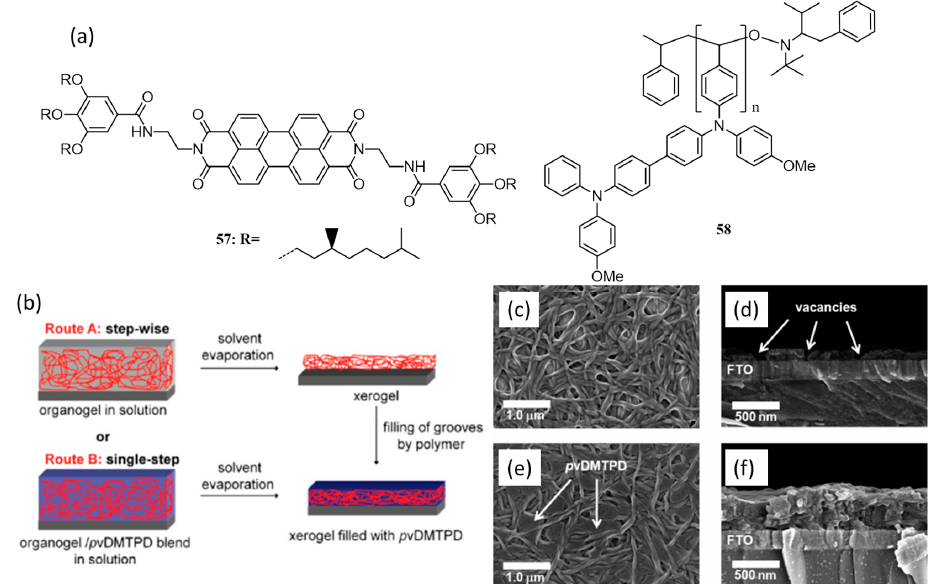
Figure 21. ( a ) Chemical structures of 57 and 58 synthesized by Würthner et al. [79] and Thelakkat et al. [80] ( b ) Schematic representation of the blending of organogel and polymer via route A and route B. SEM images of ( c ) 57 -xerogel via route A and ( d ) corresponding cross section; ( e ) Surface image of 57 -xerogel/ 58 blend (3:1) via route B and ( f ) corresponding cross-section. Abbreviated by authors as 58 : poly(vinyl-dimethoxytetraphenylbenzidine) ( pv DMTPD). Adapted with permission from Ref. [81] Copyright 2009 American Chemical Society.